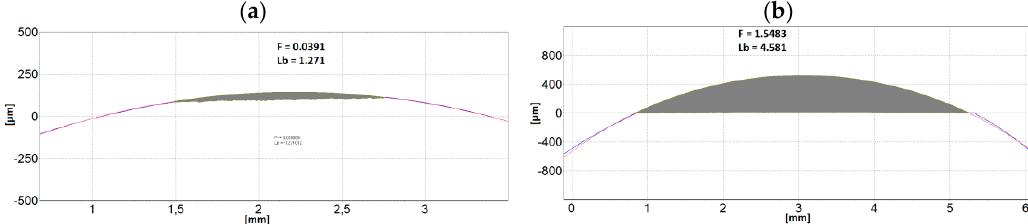
Figure 12. Examples of 2D transverse profiles of pins: ( a ) Al 2 O 3 ; ( b ) 19MnB4 steel in the wear trace